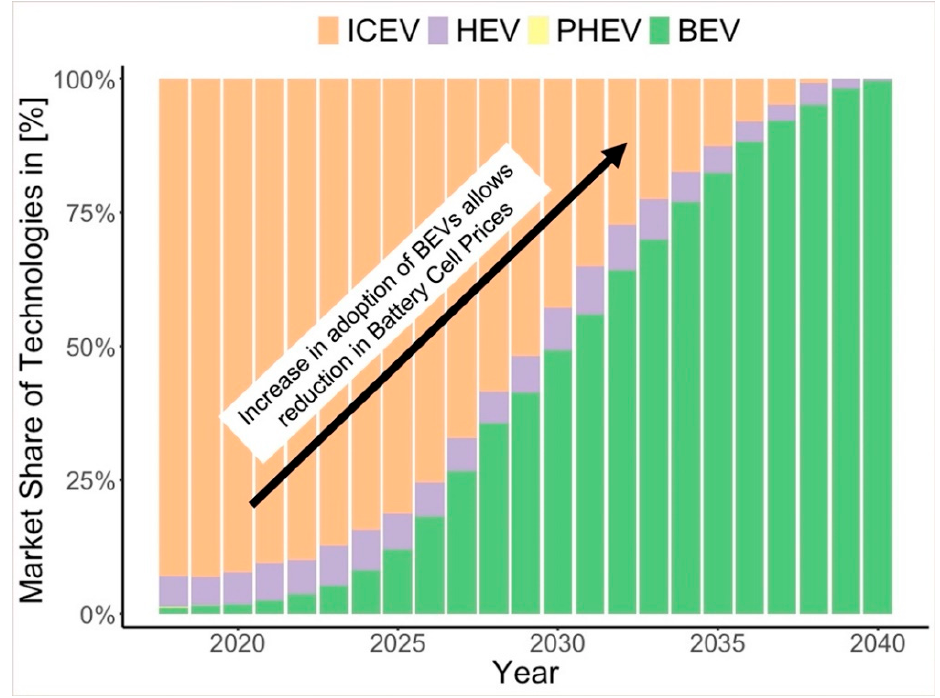
Figure 3. Future annual market share of vehicle technologies for the case of the High Non-Battery Cost Model with ICEV Cost Premium, with heterogeneous consumers (HEV = Hybrid Electric Vehicle; BEV = Battery Electric Vehicle; PHEV = Plug-in Hybrid Electric Vehicle; ICEV = Internal Combustion Engine Vehicle). Note that PHEV adoption is small enough to be invisible in this set of